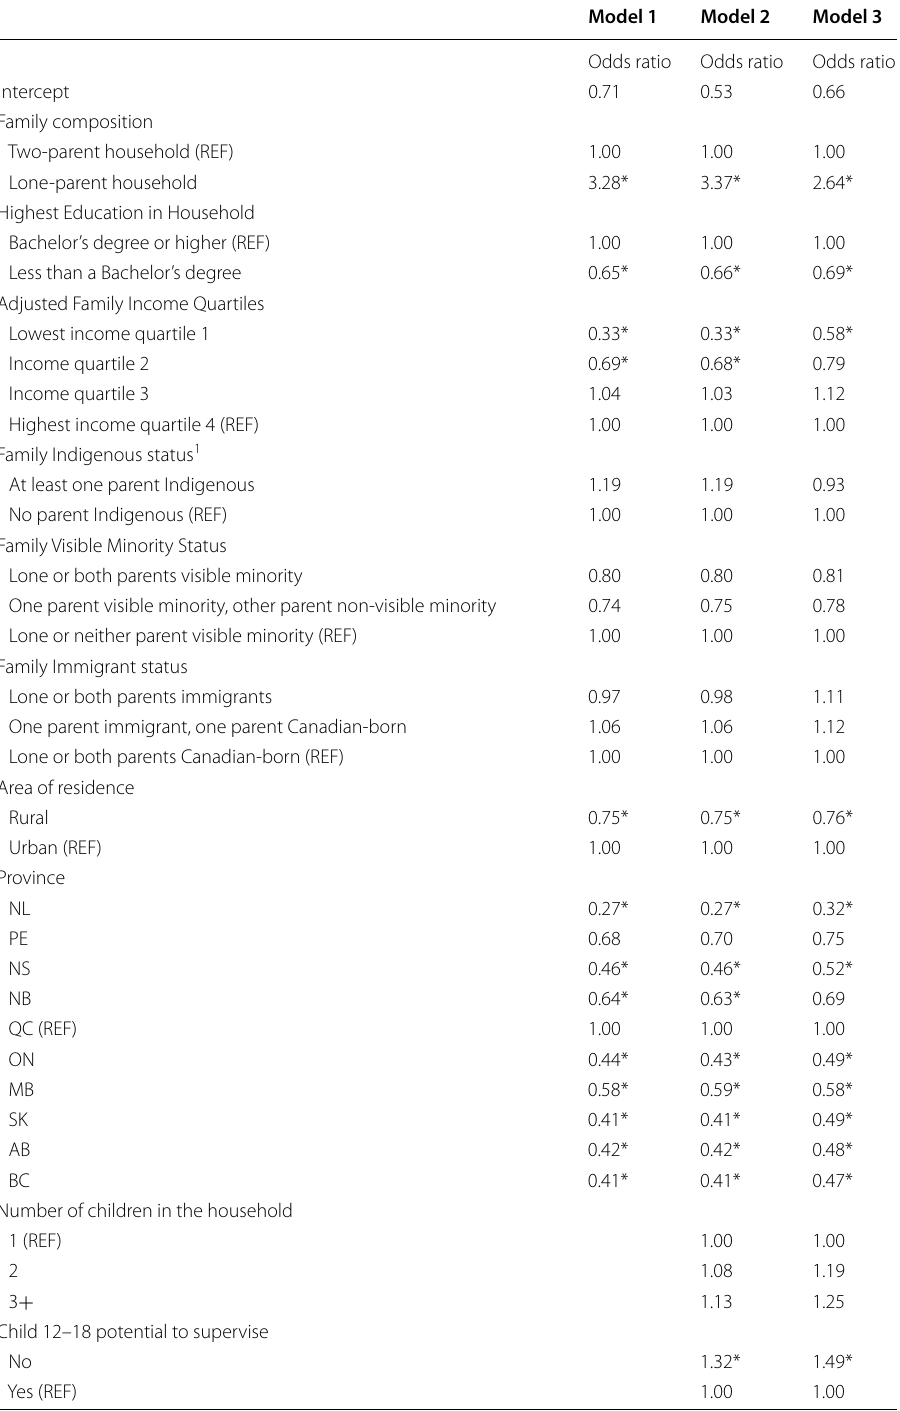
Table 2 Logistic regression predicting claimants of the child care expense deduction among families with a child less than